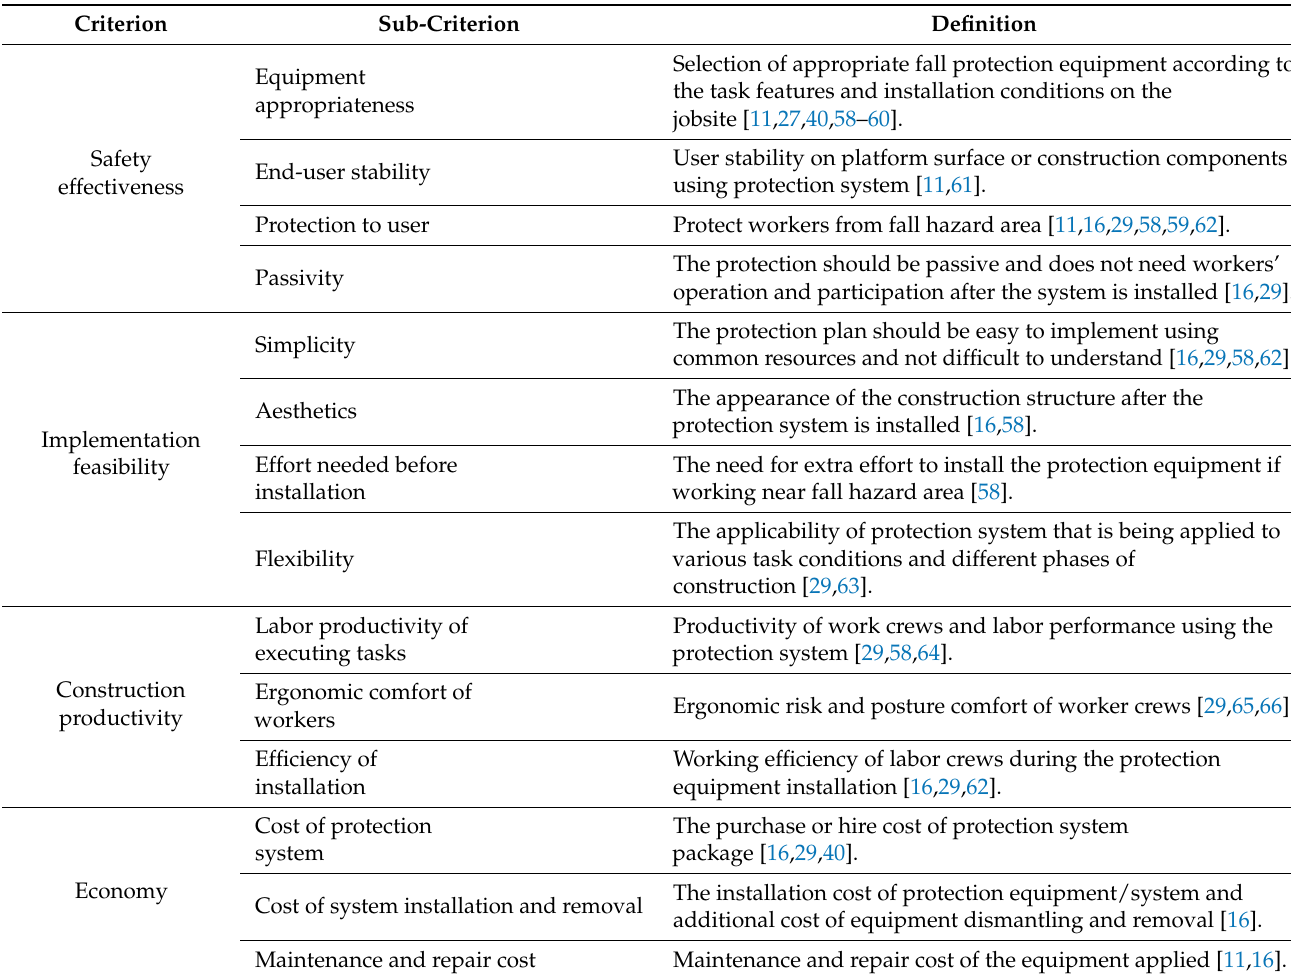
Table 1. Evaluation criteria for fall protection system